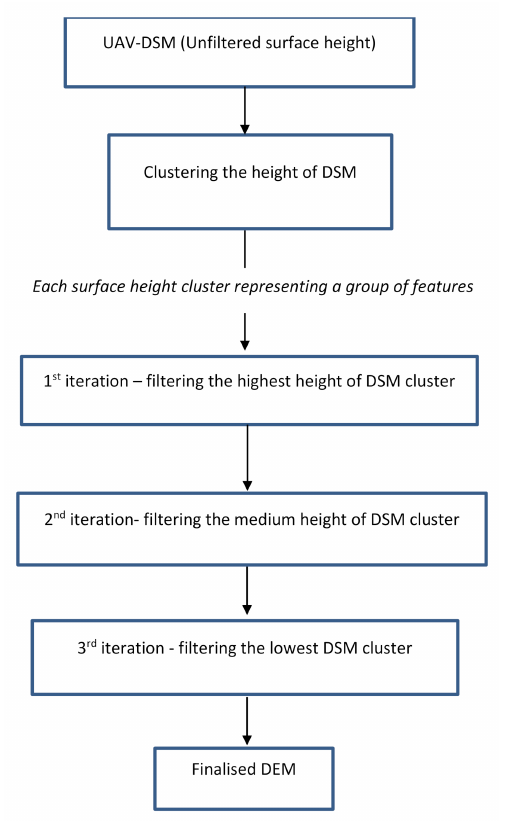
Figure 3. The specific vegetation filtering workflow using the SNERL filtering